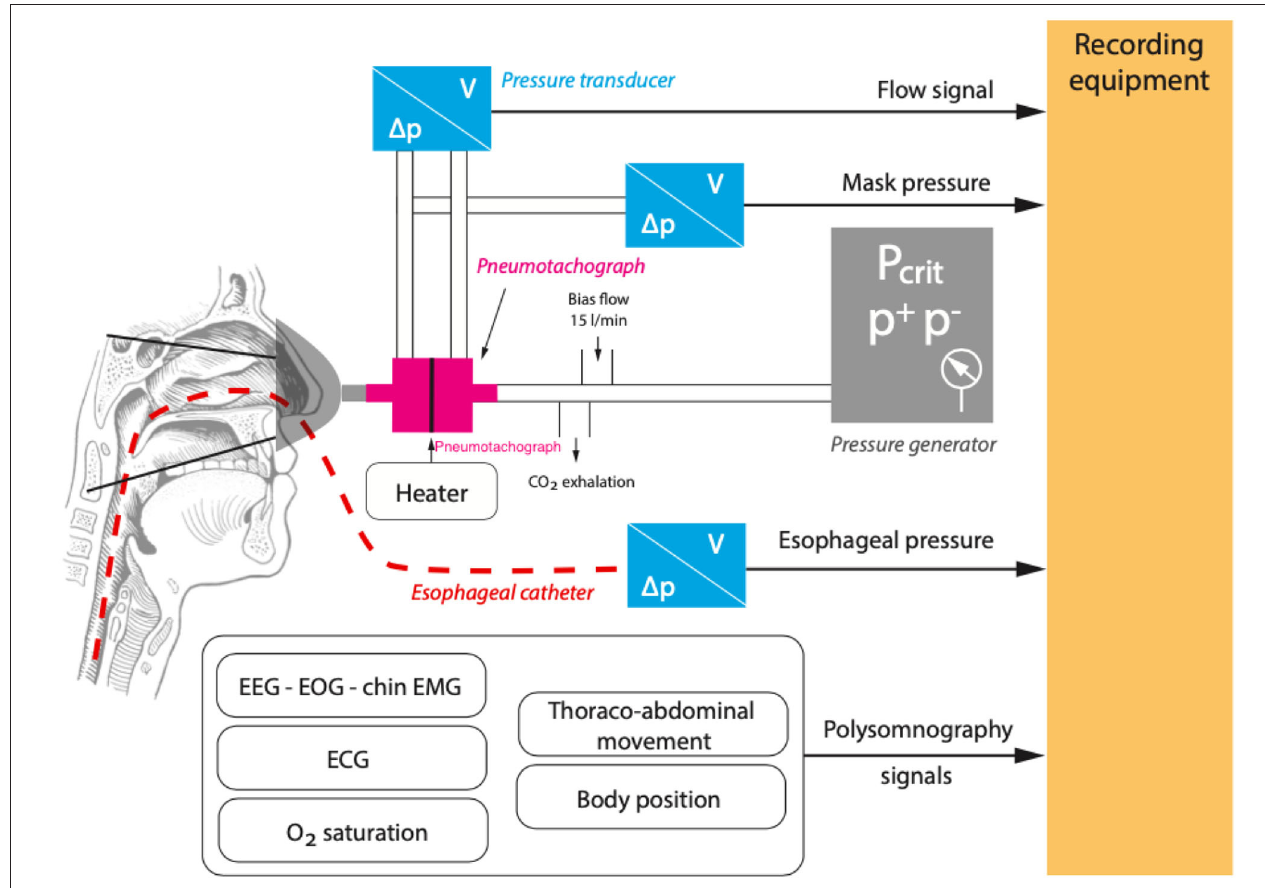
(between portions a and b on Figure 1 ) and a lower inflection point were identified (between portions b and c on Figure 1